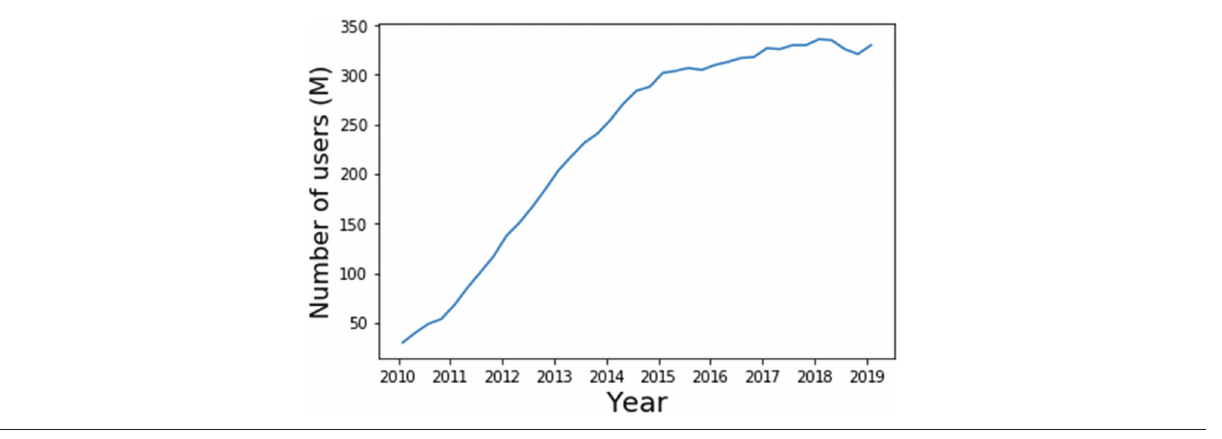
Figure 1. The number of active Twitter users as a function of time (Source: Authors,